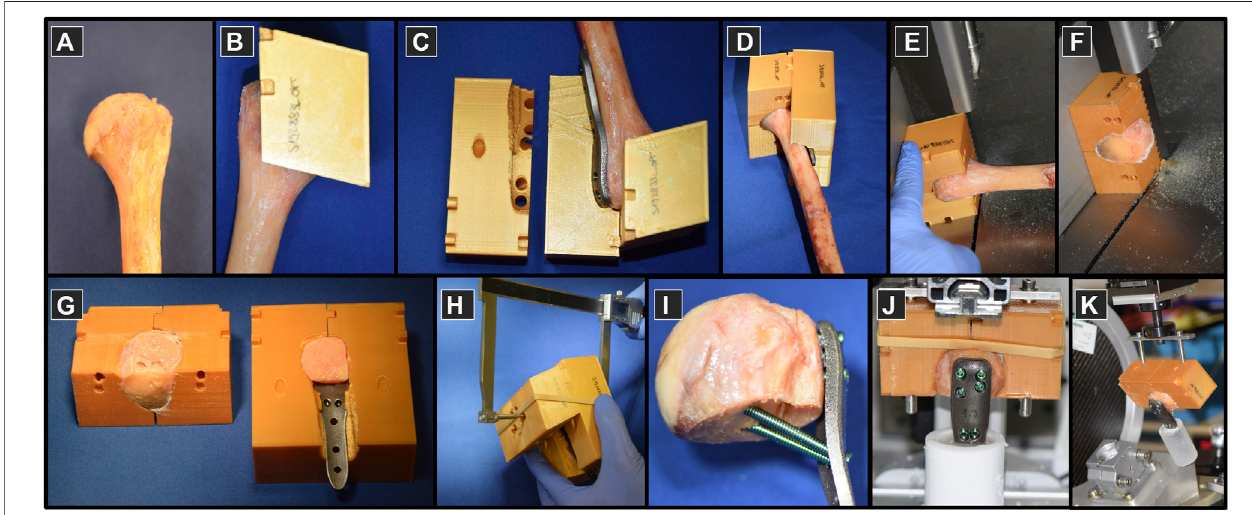
FIGURE 4 | Specimen preparation on proximal humeri (A) using custom 3D-printed plastic guides (B – D) used to assist the process of osteotomizing (E,F) , fragment reduction and implant positioning (G) , instrumentation (H,I) , embedding (J) and mounting to the experimental setup for biomechanical testing (K) .